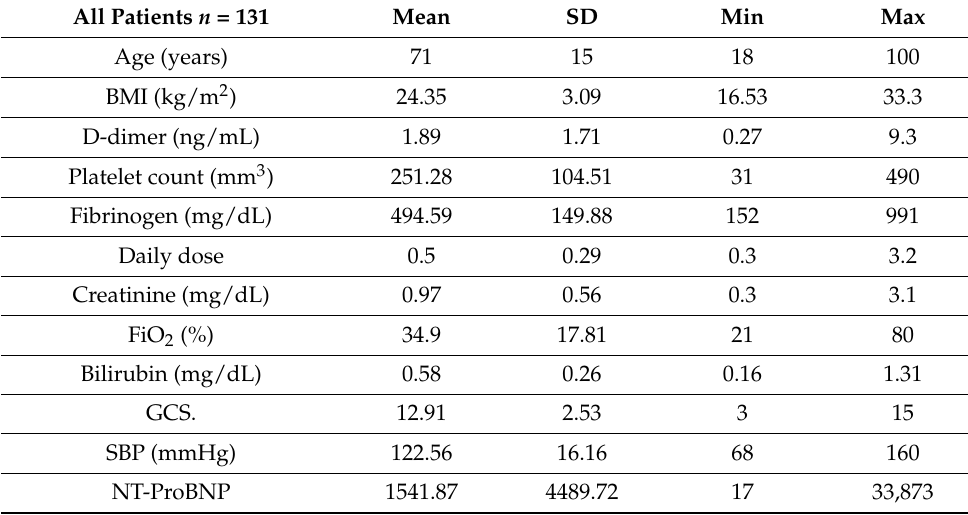
Table 1. Characteristics of COVID-19 study population. BMI = Body Mass Index; FiO 2 = fraction of inspired oxygen; GCS. = Glasgow Coma Scale; SBP = Systolic Blood